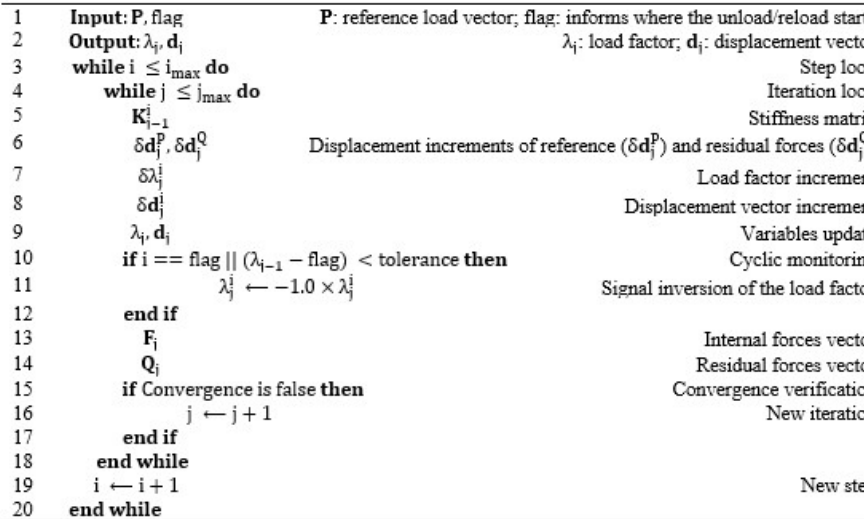
Figure 7. Standard Newton-Raphson algorithm, including the cyclic monitoring.